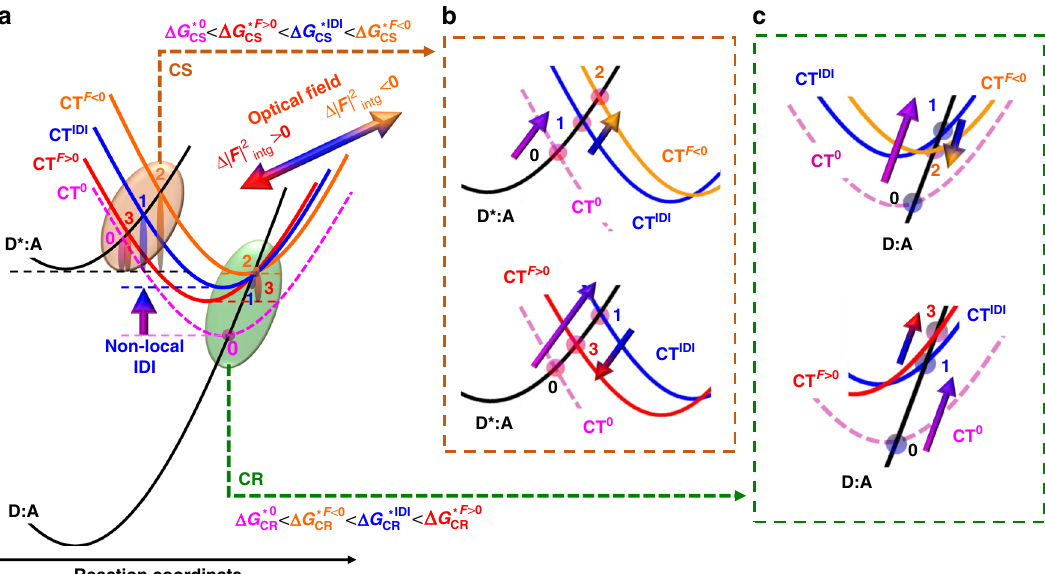
Fig. 7 Schematic representation of charge-transfer dynamic nanophotonic control by nonlocal enhanced optical- fi eld effects. a Potential energy pro fi les as a function of the reaction coordinates. b , c close-up views of the brown (CS: charge separation) and green (CR: charge recombination) ellipses, respectively. S 0 and S 1 are the donor ground and fi rst excited states, while CT x are the Donor:Acceptor (D:A) system charge-transfer states on fused silica ( x : 0), and composite nanostructures without ( x : image-dipole interaction — IDI) and with ( x : F ) the optical- fi eld effect. The vertical stretched ellipses illustrate the activation energy ( Δ G *) variations. Details and magni fi cations are given in the Supplementary Information. The numbers 0,1,2,3 correspond to those shown in Fig.